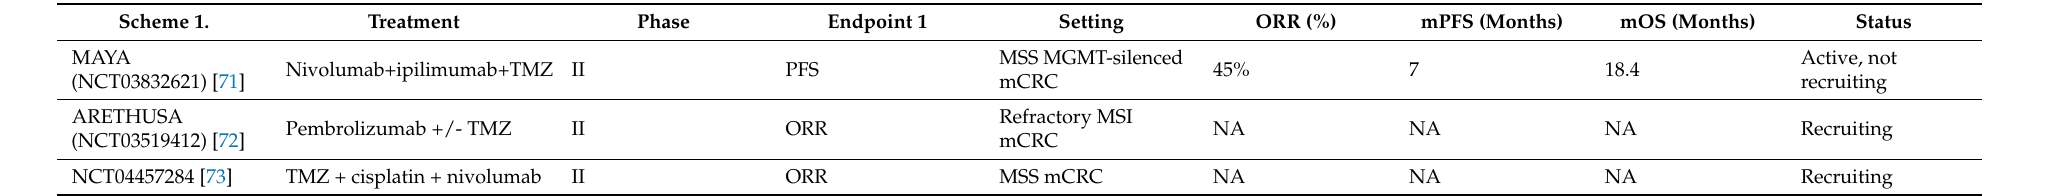
Table 4. Currently ongoing and completed clinical trials of TMZ and ICIs in MSS mCRC. Scheme